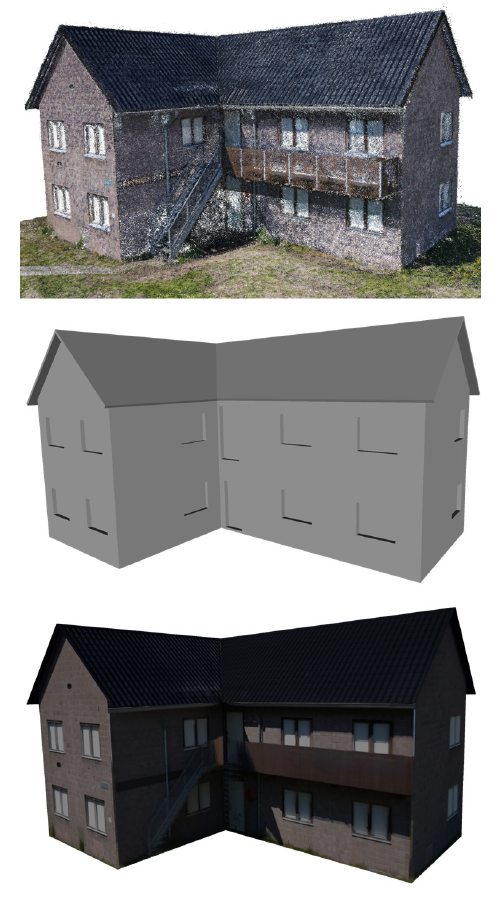
Figure 11. Reconstruction of an L-shaped